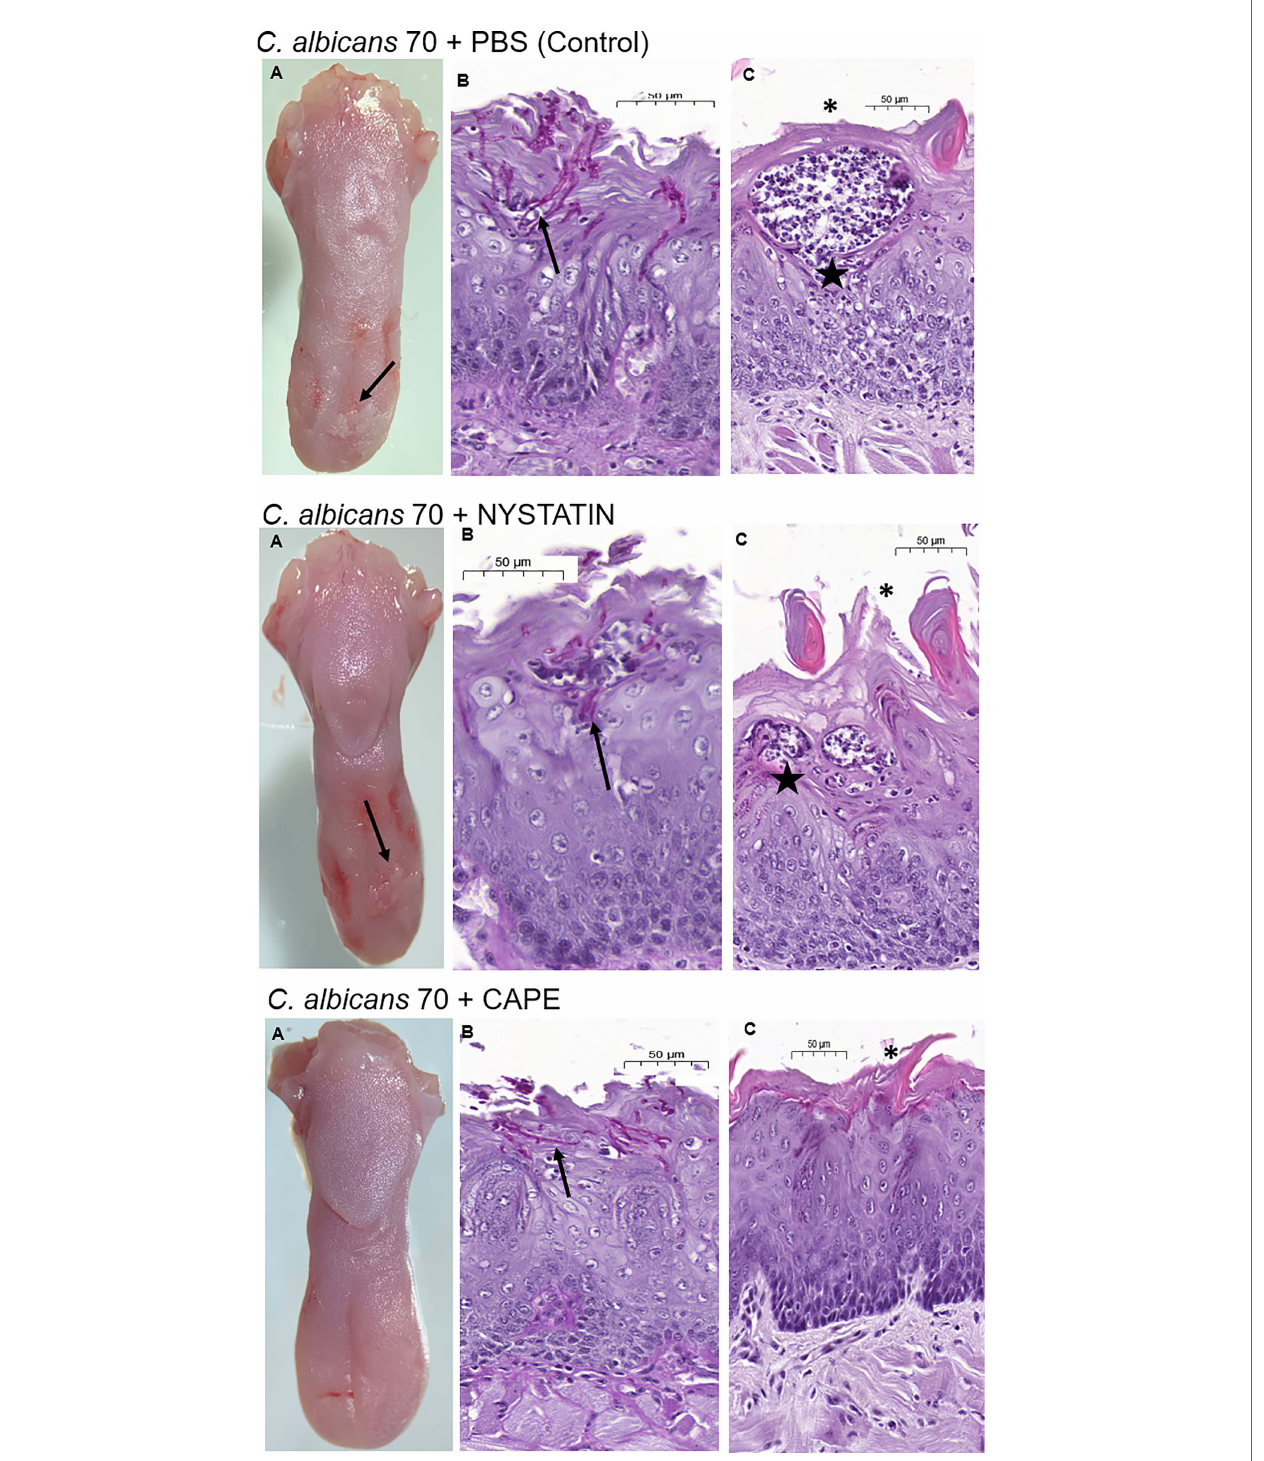
FIGURE 11 | Analysisofthe dorsum tongue of mice infected with C. albicans . The mice were treated with PBS (control group, toprow),nystatin (middlerow) andCAPE (bottomrow). (A) White patches of candidiasis( ! ) can beobserved inthe macroscopicanalysisof the untreated group and the one treated with nystatin. (B) PAS sections, showinghyphae and yeast inthe epithelium-keratinizedlayer ( ! ). (C) Images ofhistological cuts stained byH&E, where intraepithelialmicroabscesses ( ☆ ) and loss of fi liform papillae were observed( *